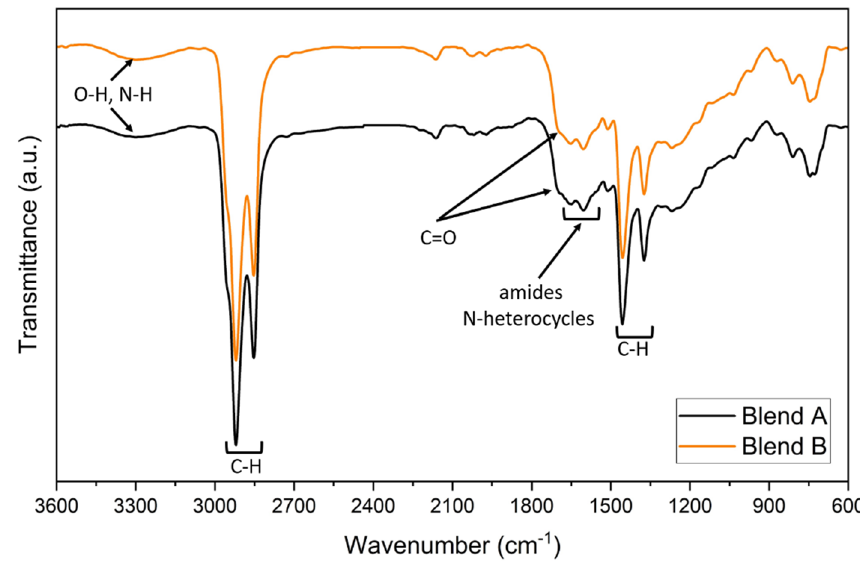
Figure 6. FT-IR spectrum of 10% and 20% SS biocrude blends.